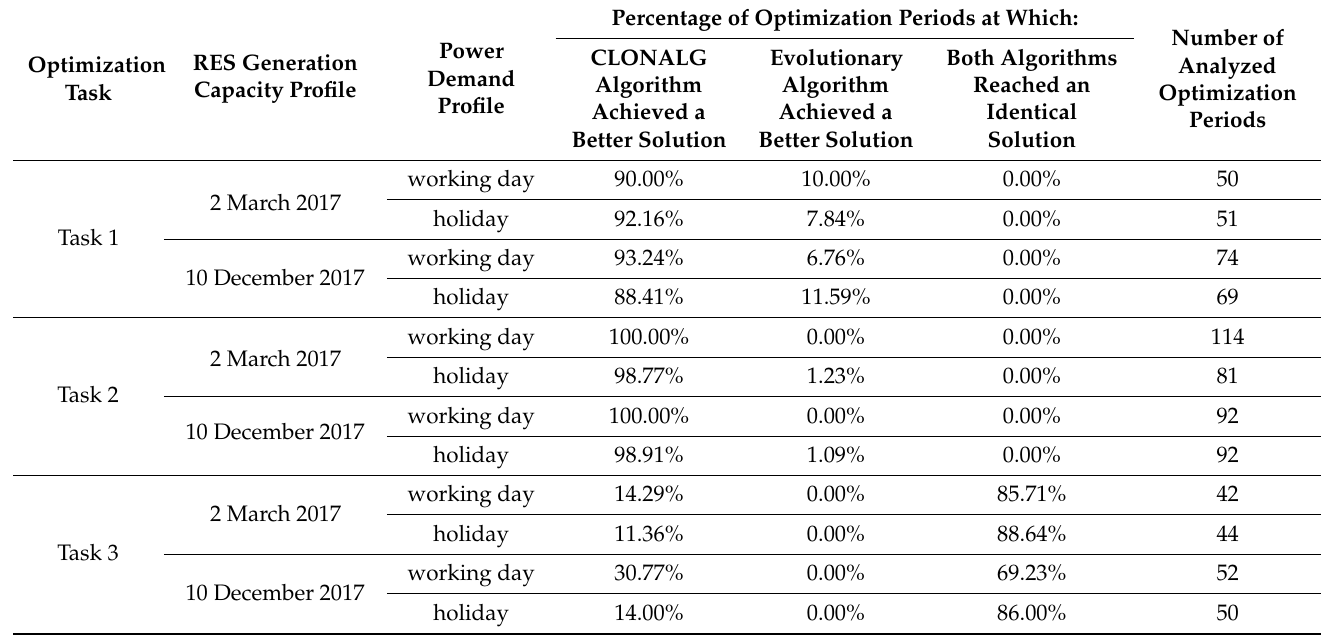
Table 8. Comparison of results of optimization calculations for the microgrid island operation.